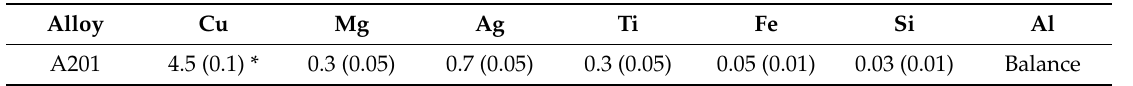
Table 1. Chemical composition of the experimental alloy (wt.%) .